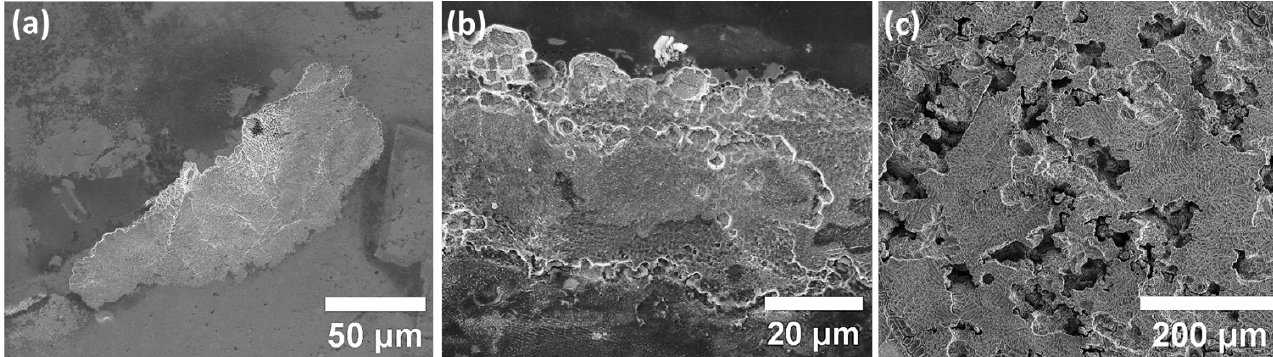
Figure 6. SEM microstructural analysis of the corroded surface of specimens of as-received polished state of ( a ) group one, ( b ) group two, and ( c ) group three highlighting the morphology of corrosion